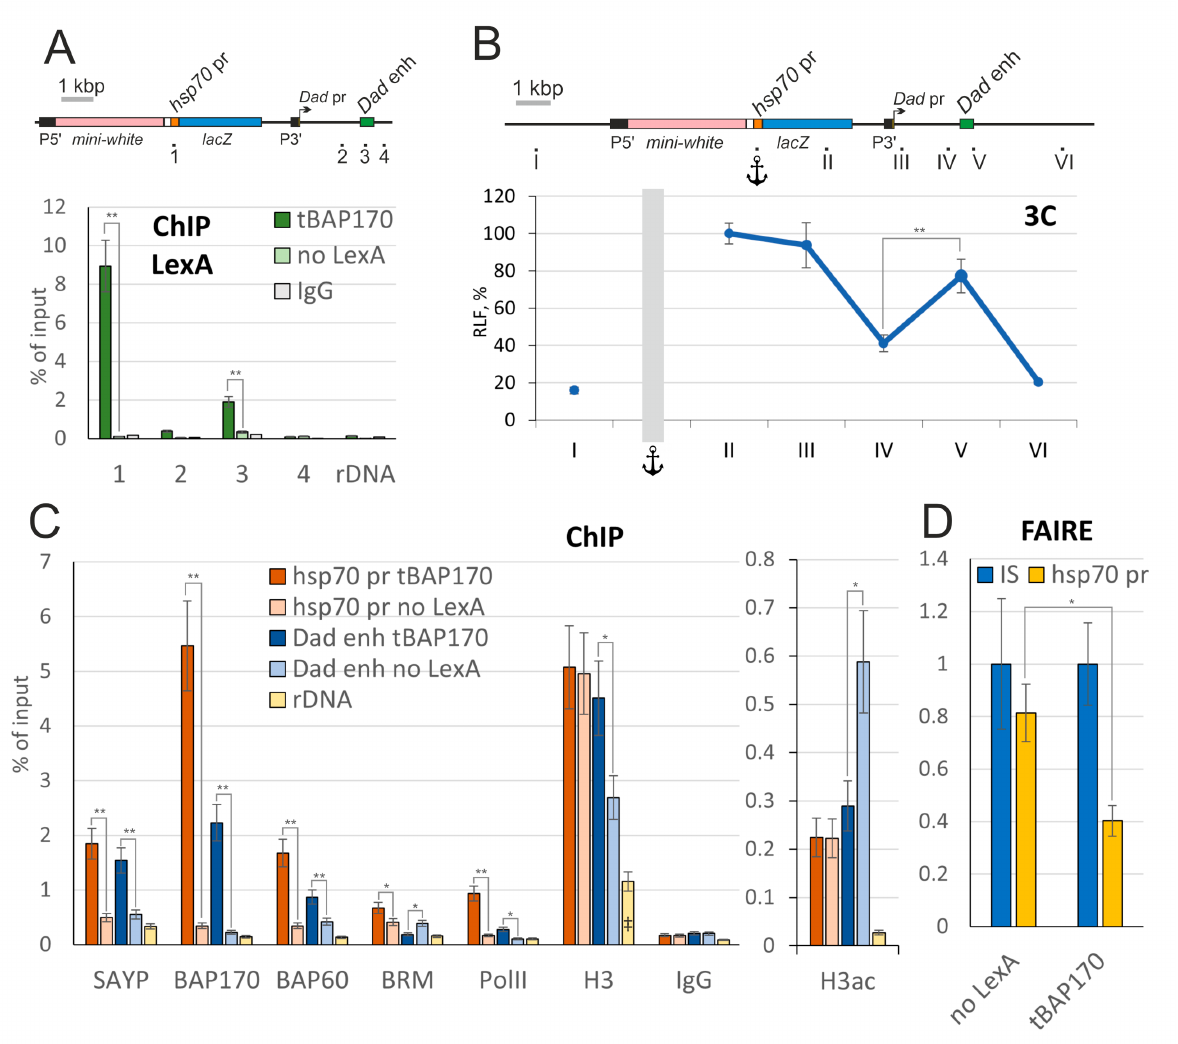
Figure 5. Analysis of the chromatin state in the lexAop-LacZ Dad responder line expressing the LexA:BAP170 fusion. ( A ) ChIP profile of LexA:BAP170 fusion binding along the transgenic Dad locus (a scheme is given at the top). Loci 1–4 indicate the positions in the transgenic Dad locus. IgG (pre-immune immunoglobulin) and rDNA (ribosomal 28S RNA gene) were used as negative controls. Flies expressing LexA:BAP170 were taken for the analysis; no-LexA flies are control flies, which did not express the LexA fusion. The results of ChIPs are presented as percentages of the input. ( B ) 3C analysis of the chromatin conformation in the transgenic Dad locus (a scheme is given at the top). Loci I-VI were checked for the relative ligation frequency (RLF) with the anchor located at the hsp70 promoter. RLF is given as percent, 100% corresponding to the efficiency of anchor–point II ligation. ( C ) Recruitment of different proteins onto the hsp70 reporter promoter, Dad enhancer, and rDNA. The LexA fusion and subunits of the PBAP complex are indicated at the bottom. PolII, RNA polymerase II; H3, histone H3; H3ac, acetylated H3. Flies expressing LexA:BAP170 and no-LexA flies were taken for the analysis. The level of a factor is shown as a percentage of Input; H3ac was normalized to H3. (‡) The level of H3 on rDNA is shown 10 times lower than actual. ( D ) FAIRE signal at the hsp70 promoter relative to the control region (intergenic spacer, IS), which was set as 1. Control flies (no LexA) and flies expressing LexA:BAP170 fusion were tested. Asterisks indicate significance levels: * p < 0.05 and ** p <